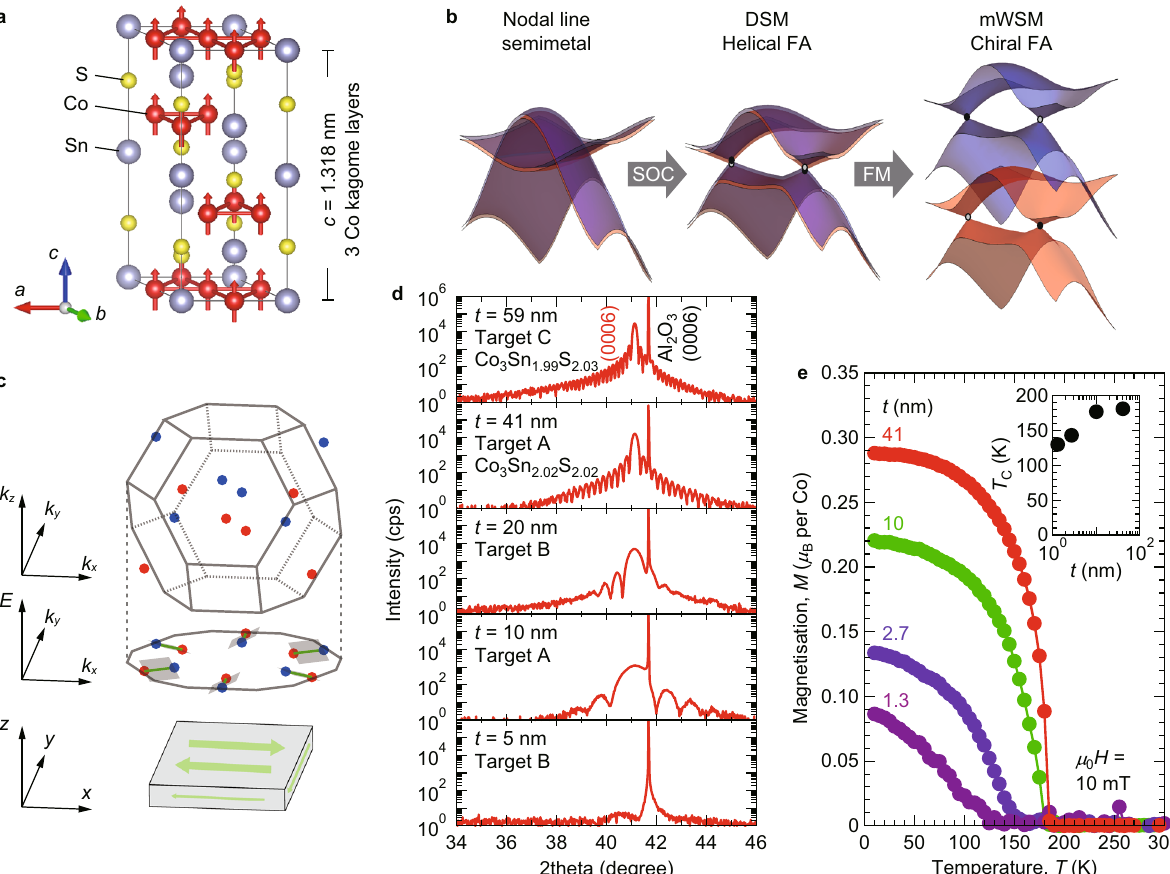
Fig. 1 Thin fi lms of kagome-lattice ferromagnet Co 3 Sn 2 S 2 . a Crystal structure of Co 3 Sn 2 S 2 and the ferromagnetic spin ordering below T C drawn with VESTA 28 . b Schematic band structures of nodal line semimetal, DSM, mWSM (FM: ferromagnetic coupling). Band crossing points, that is, Dirac and Weyl points, are represented by black and grey ellipsoids. c Distribution of Weyl points in energy – wave number ( E – k ) space and electrial conduction via chiral FA states in real space. Weyl points with opposite spin chiralities are represented by red and blue circles. d Typical out-of-plane XRD patterns of Co 3 Sn 2 S 2 fi lms with varied t . Three different targets (A, B and C) were used to check the reproducibility of the fi lm composition and quality. For t ≥ 40 nm, the fi lm compositions determined by EDX are shown. e M versus T curves measured for t = 41, 10, 2.7 and 1.3 nm (fabricated with the target A) at μ 0 H = 10 mT. The inset shows the t dependence of T C